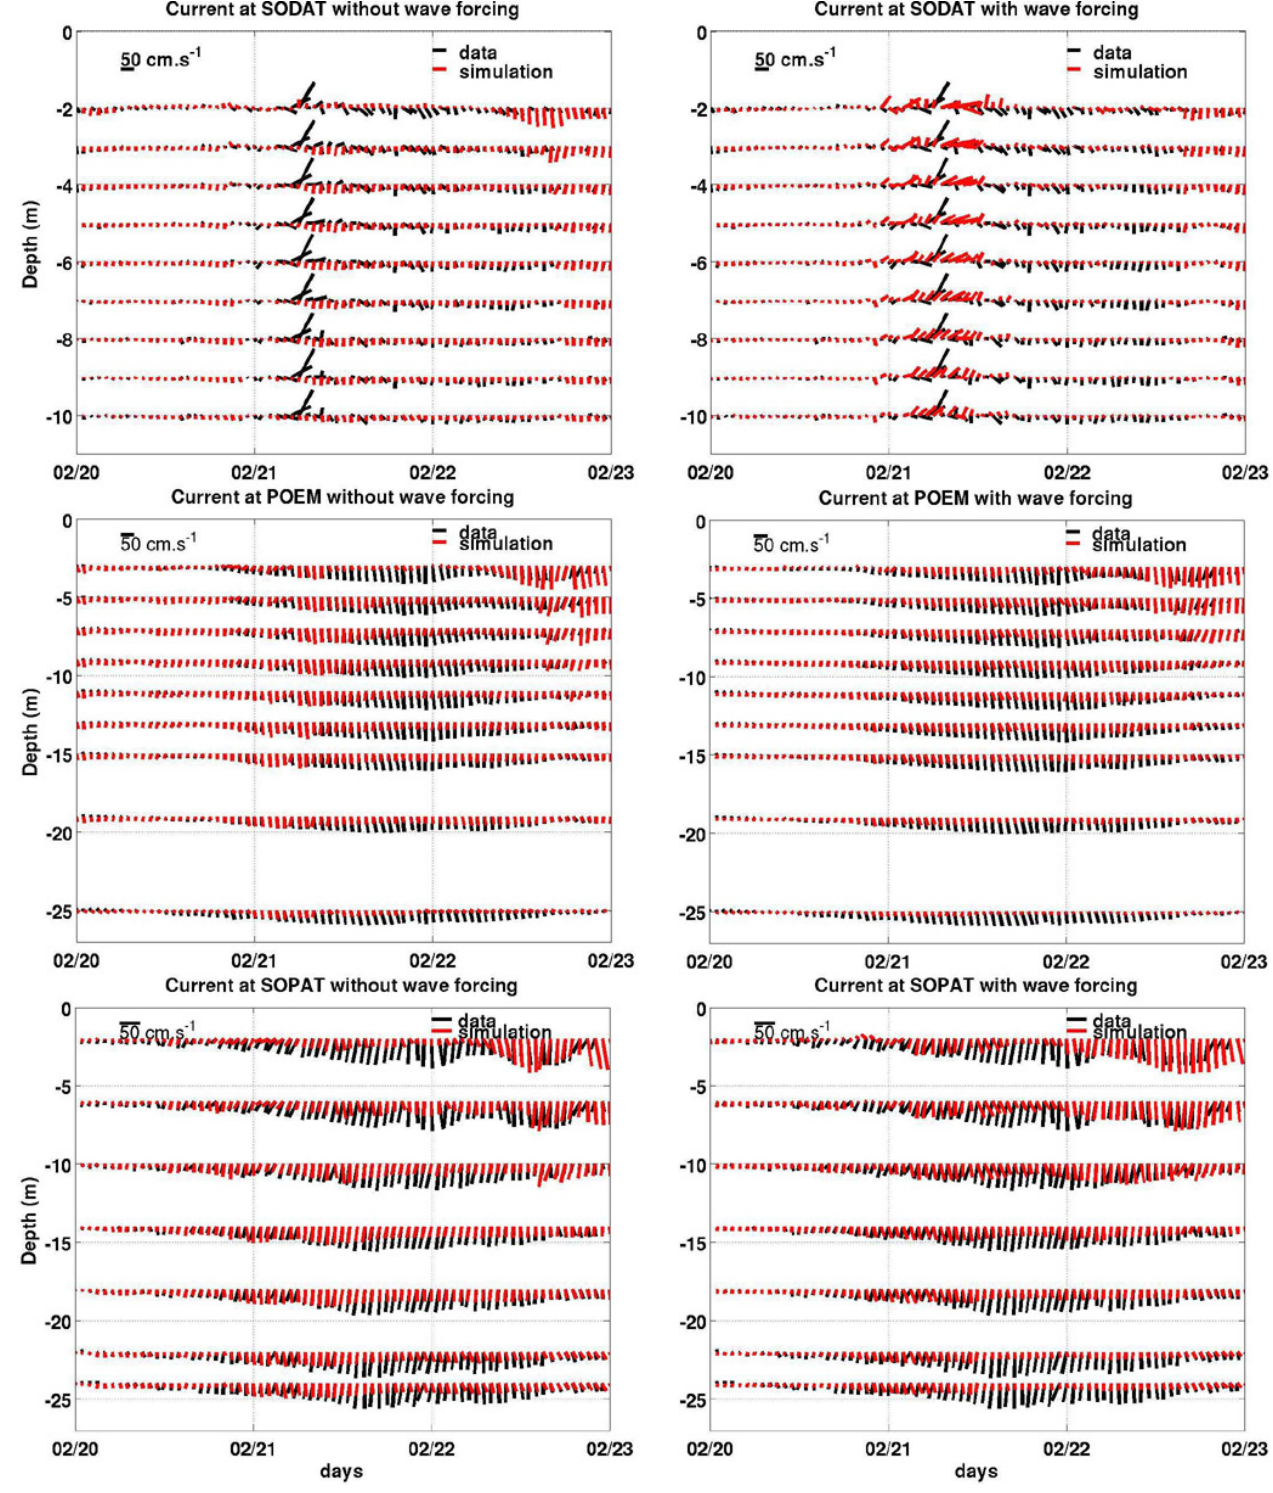
Fig. 13. Comparison of time series at the three instruments, between the measured current (black) and the simulated current (red). Left: the simulation is performed without the wave forcing, and right: the simulation is performed with the wave